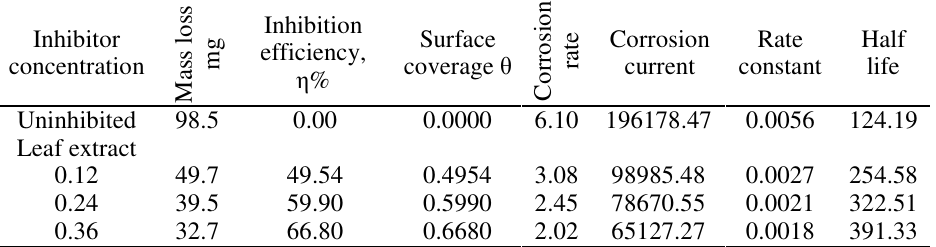
Table 3. Effect of extract of different parts of plants acacia Senegal on mass loss data